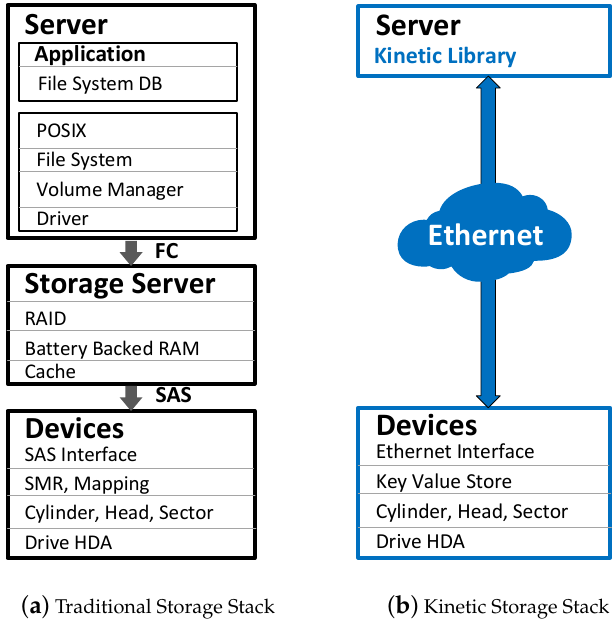
Figure 1. Traditional vs. Kinetic storage stack